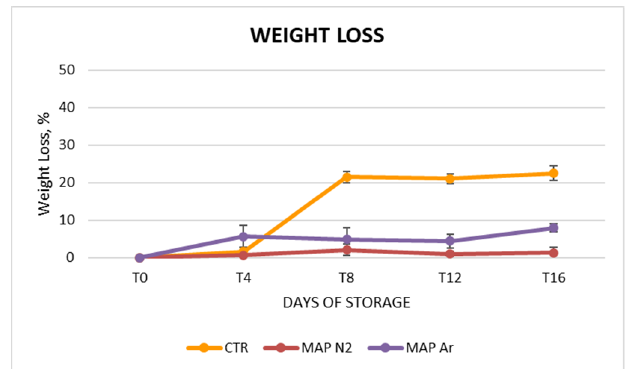
Figure 2. Trend of weight loss (%) of arils during cold storage and treated with MAP (CTR: 20.9% O 2 + 0.04% CO 2 (passive-MAP); MAPN 2 : 10% O 2 + 5% CO 2 + 85% N 2 ; MAPAr: 10% O 2 + 5% CO 2 + 85% Ar). Values were recorded at 0 (T 0 ), 4 (T 4 ), 8 (T 8 ), 12 (T 12 ), and 16 (T 16 ) days at 4 ± 1 °C and 90 ± 5% RH. Values represented as mean ± SD. of each treatment for each date.